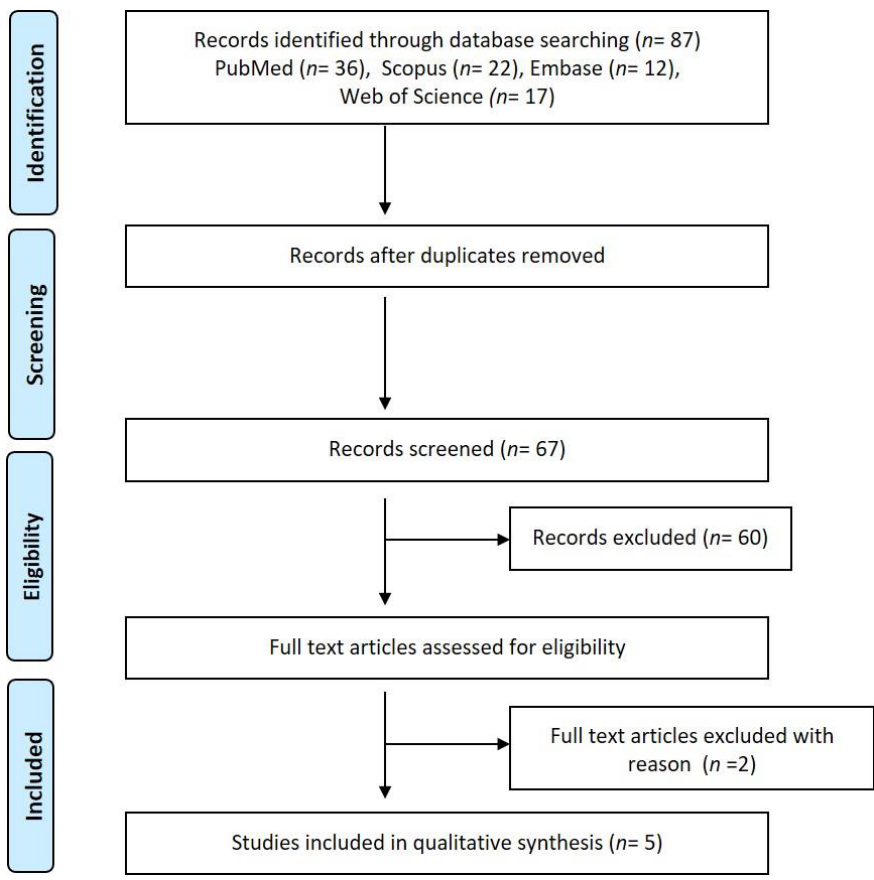
Figure 1. PRISMA flow diagram depicting the methodology of the review. Table 2. Characteristics of selected studies.